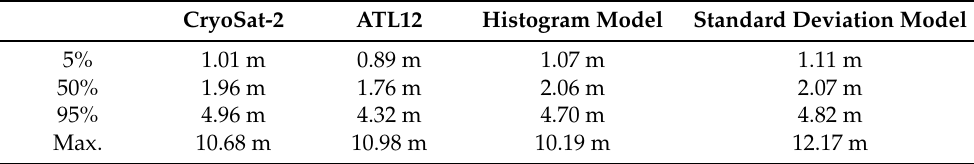
Table 2. Distribution of SWH observations for each